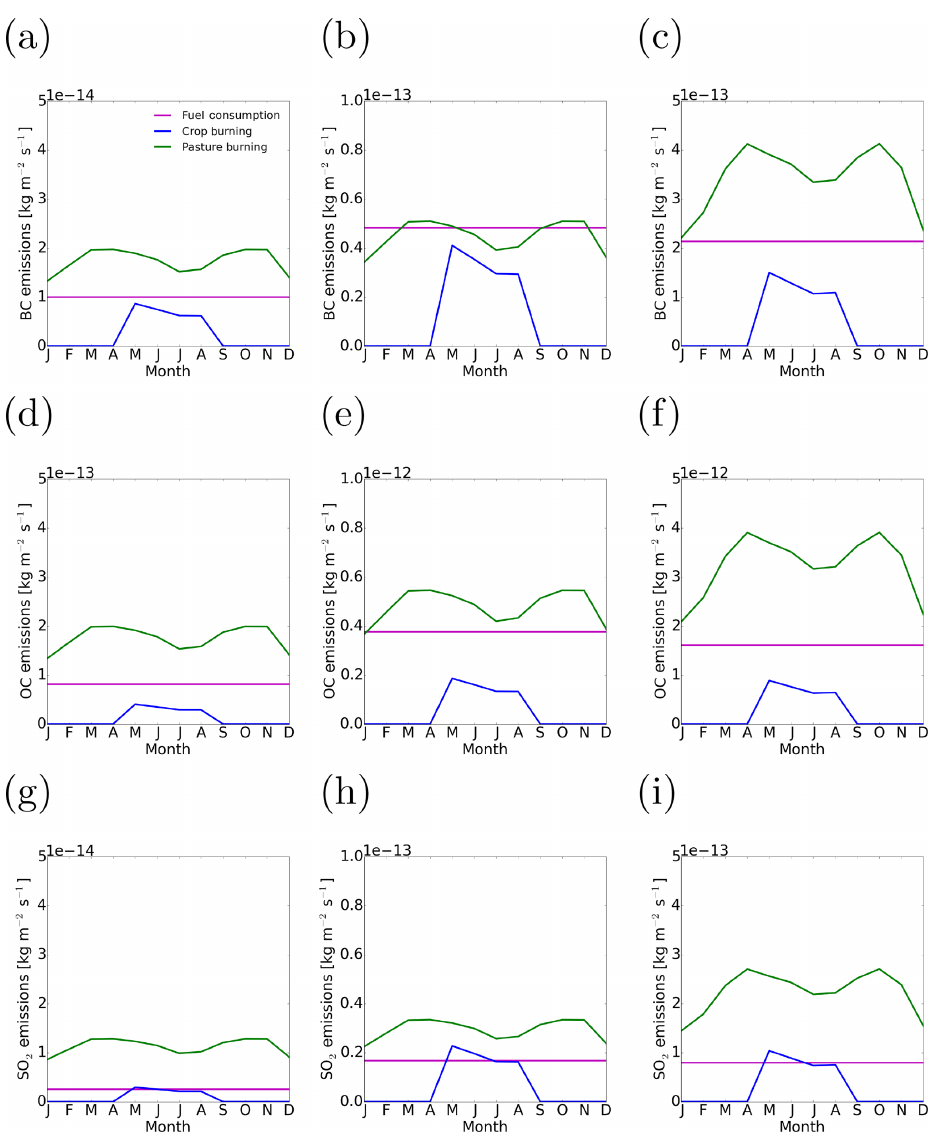
Figure 3. Monthly mean anthropogenic aerosol emissions due to fuel consumption, crop residue burning, and pasture burning in the study domain over the year. (a) – (c) BC; (d) – (f) OC; (g) – (i) SO 2 emissions. (a, d, g) Low emission scenario; (b, e, h) intermediate emission scenario; (c, f, i) high emission scenario. Note the different scales on the y axis.